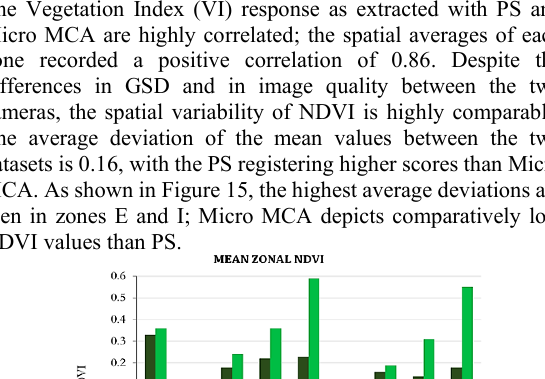
Figure 13 (a) Inliers vs outliers (b) Boxplots of paired distances